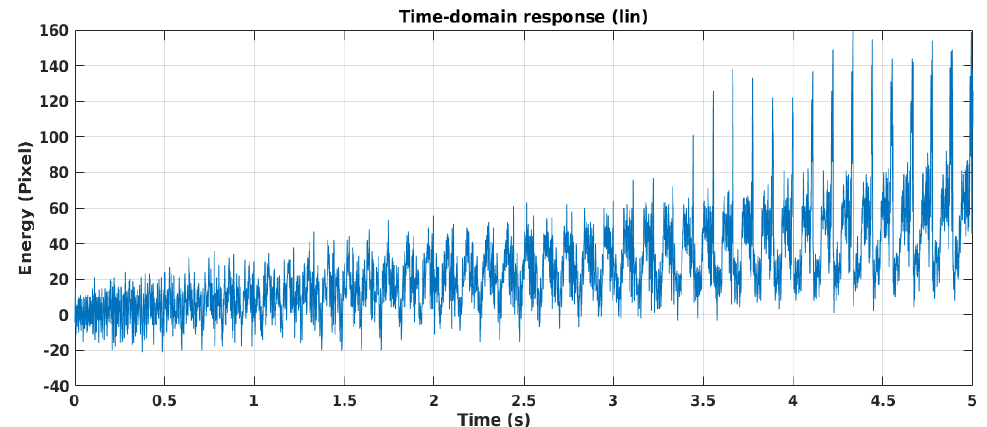
Figure 20. Time domain vibration trend.